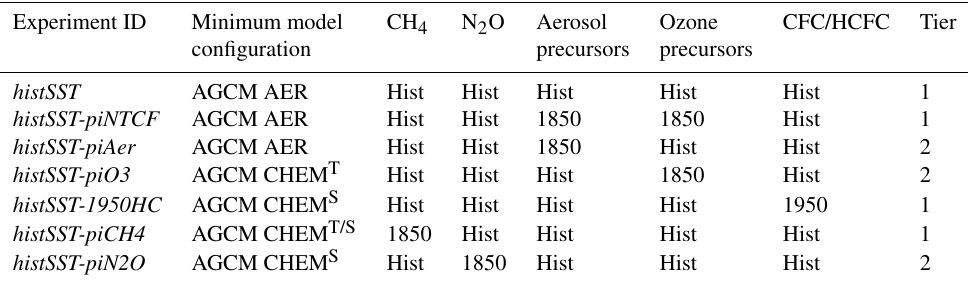
Table 2. List of historical prescribed SST experiments. Experiments cover the period between 1850 and 2014, except histSST-1950HC , which starts in 1950. The “AER” suffix means models should at least calculate tropospheric aerosols driven by emission fluxes. The “CHEM T ” or “CHEM S ” suffix means that at least tropospheric or stratospheric chemistry are required. Models should always be run with the maximum complexity available. The species columns refer to the specifications for concentrations (CH 4 , N 2 O and CFC/HCFC) or emissions (aerosol and ozone precursors). “Hist” means the concentrations or emissions should evolve as for the CMIP6 historical simulation; a year means the concentrations or emissions should be fixed to that year. Note that the N 2 O and HC runs will have a small forcing, but will provide valuable information on their historical impacts on stratospheric ozone